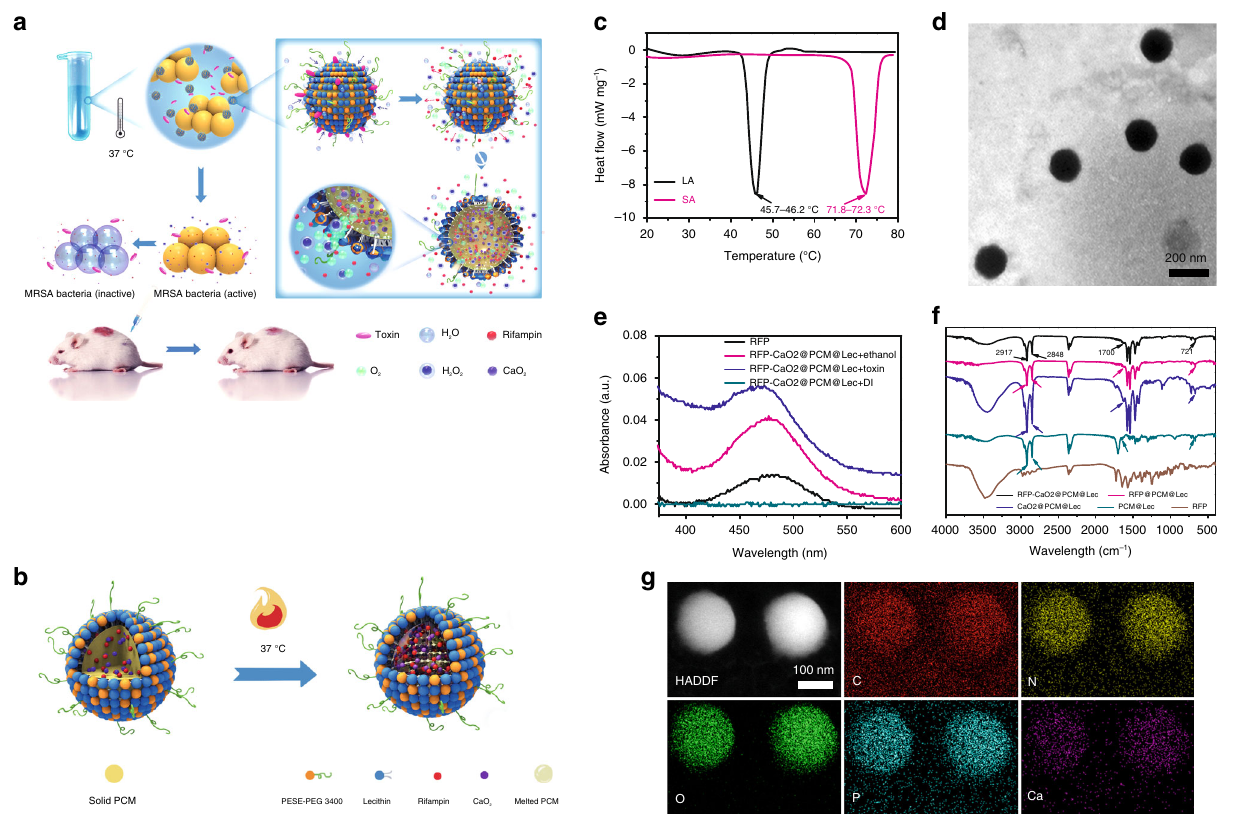
Fig. 1 Design and characterization of liposome-based nanoreactors. a The scheme of endogenous stimulus-powered antibiotic release from RFP- CaO 2 @PCM@Lec nanoreactors for bacterial infection combination therapy. b The solid PCM was dissolved in melted PCM at 37 °C. c Differential scanning calorimetry (DSC) curves of LA and SA. d A typical TEM image of the RFP-CaO 2 @PCM@Lec nanoreactors. e UV absorption spectra of RFP under different conditions. Free RFP (black), RFP in ethanol (red), in toxin (blue) and in DI water (green). f FI-IR absorption spectra of different materials. g Mapping of RFP-CaO 2 @PCM@Lec nanoreactors. Source data are provided as a Source Data fi